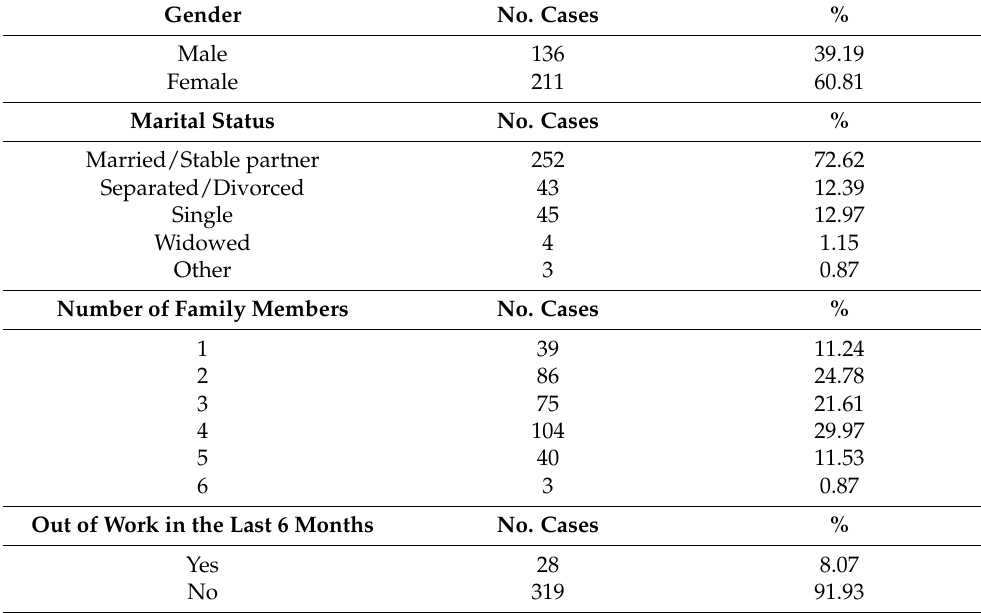
Table 1. Sociodemographic data.